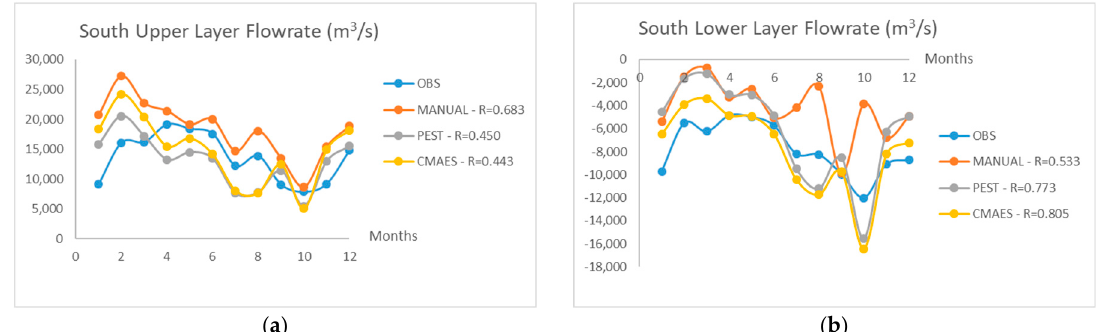
Processes 2019 , 7 , 710 Figure 7. Upper ( a ) and lower ( b ) flow rate values of the northern part of the strait.